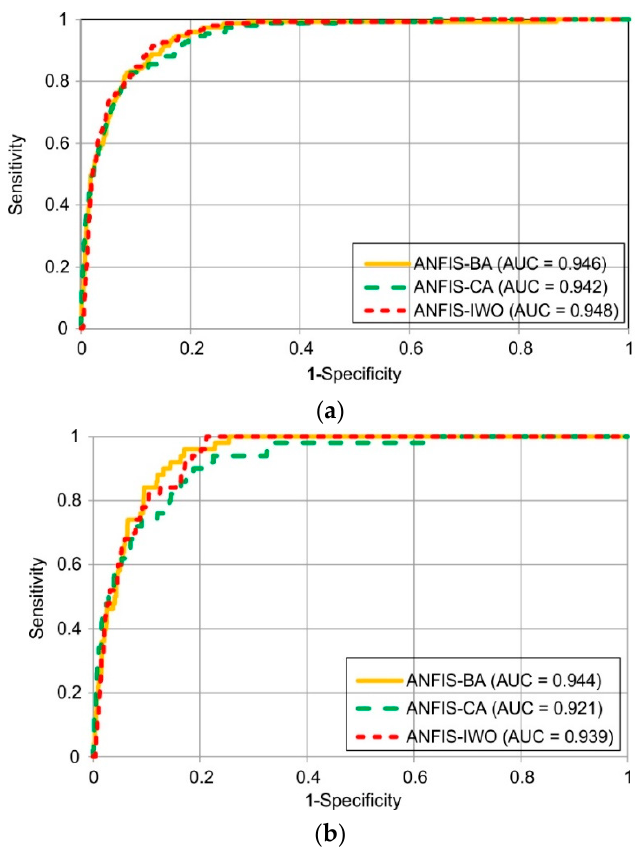
Figure 13. Model validation by success rate ( a ) and prediction rate ( b ) for three hybrid models.